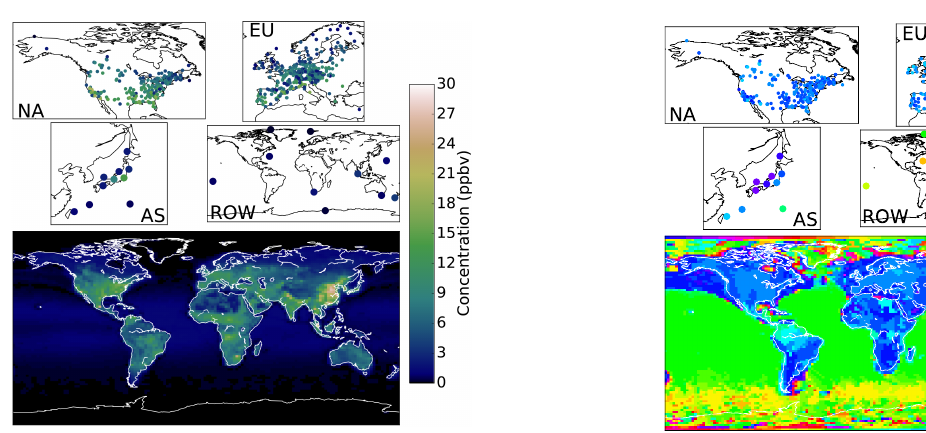
Figure 9. Diurnal phases of observations (upper panels) and model (lower panel). NA is North America, EU is Europe, AS is Asia, and ROW is rest of